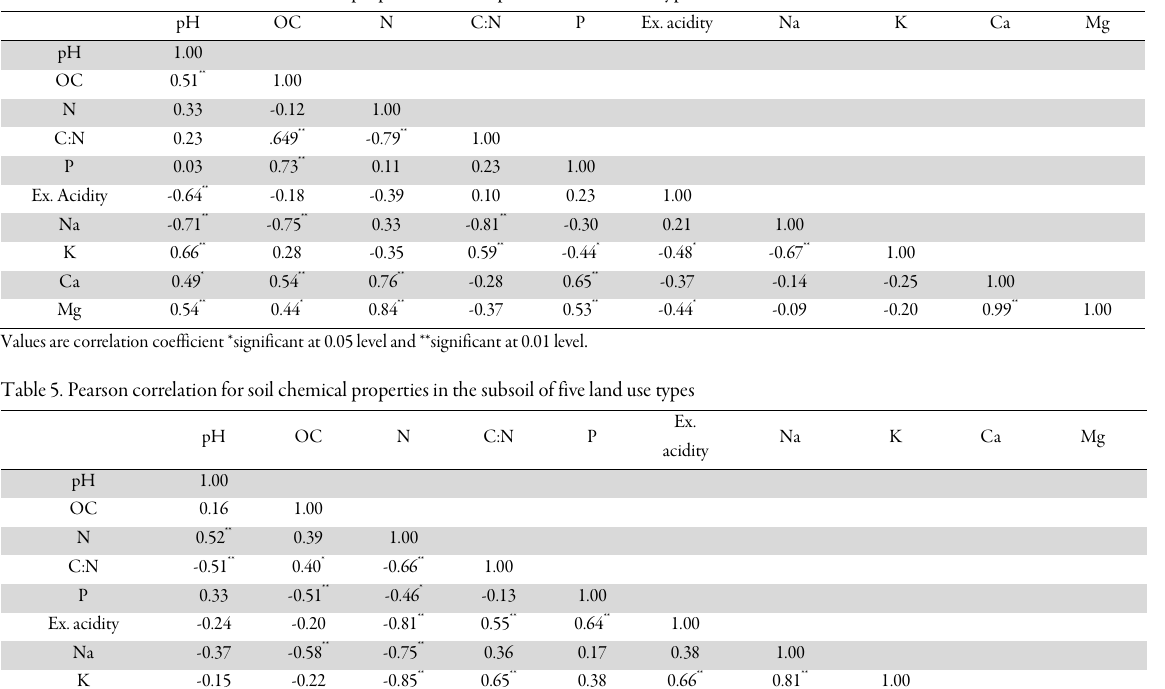
Table 4. Pearson correlation for soil chemical properties in the top soil of five land use types